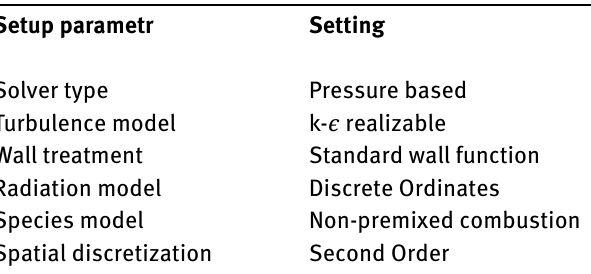
Table 3: The settings of the Fluent numerical